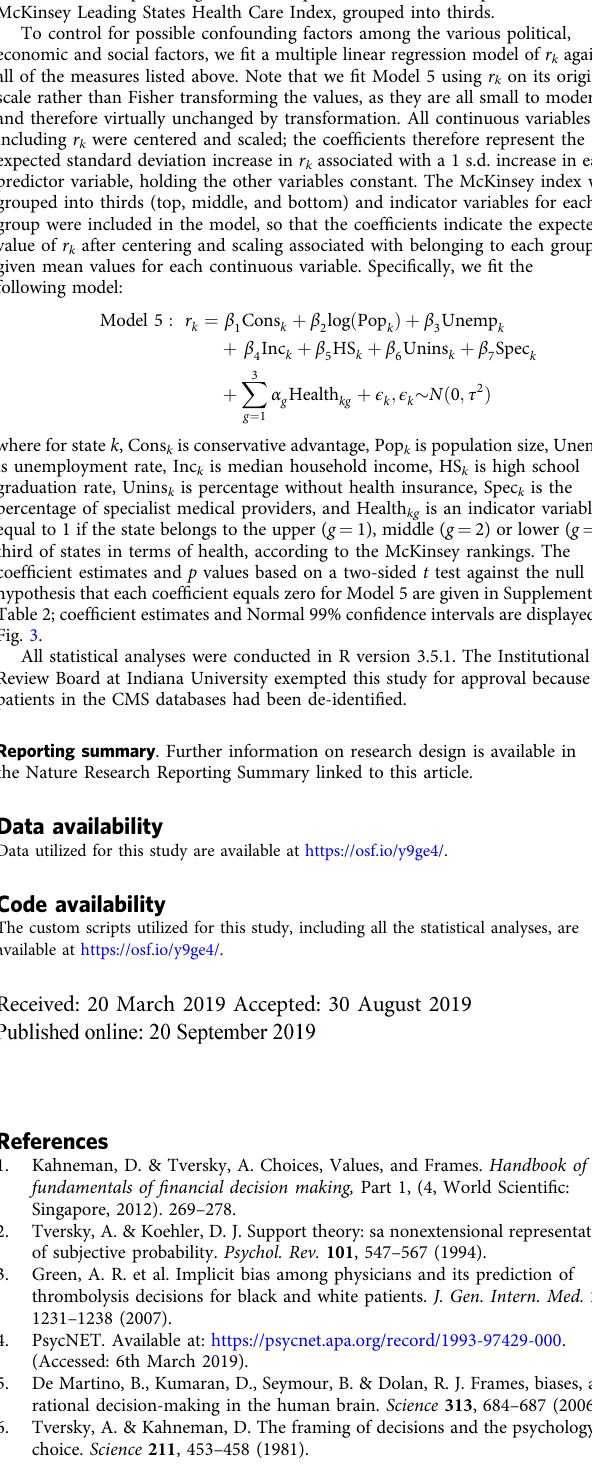
All statistical analyses were conducted in R version 3.5.1. The Institutional Review Board at Indiana University exempted this study for approval because all patients in the CMS databases had been de-identi fi